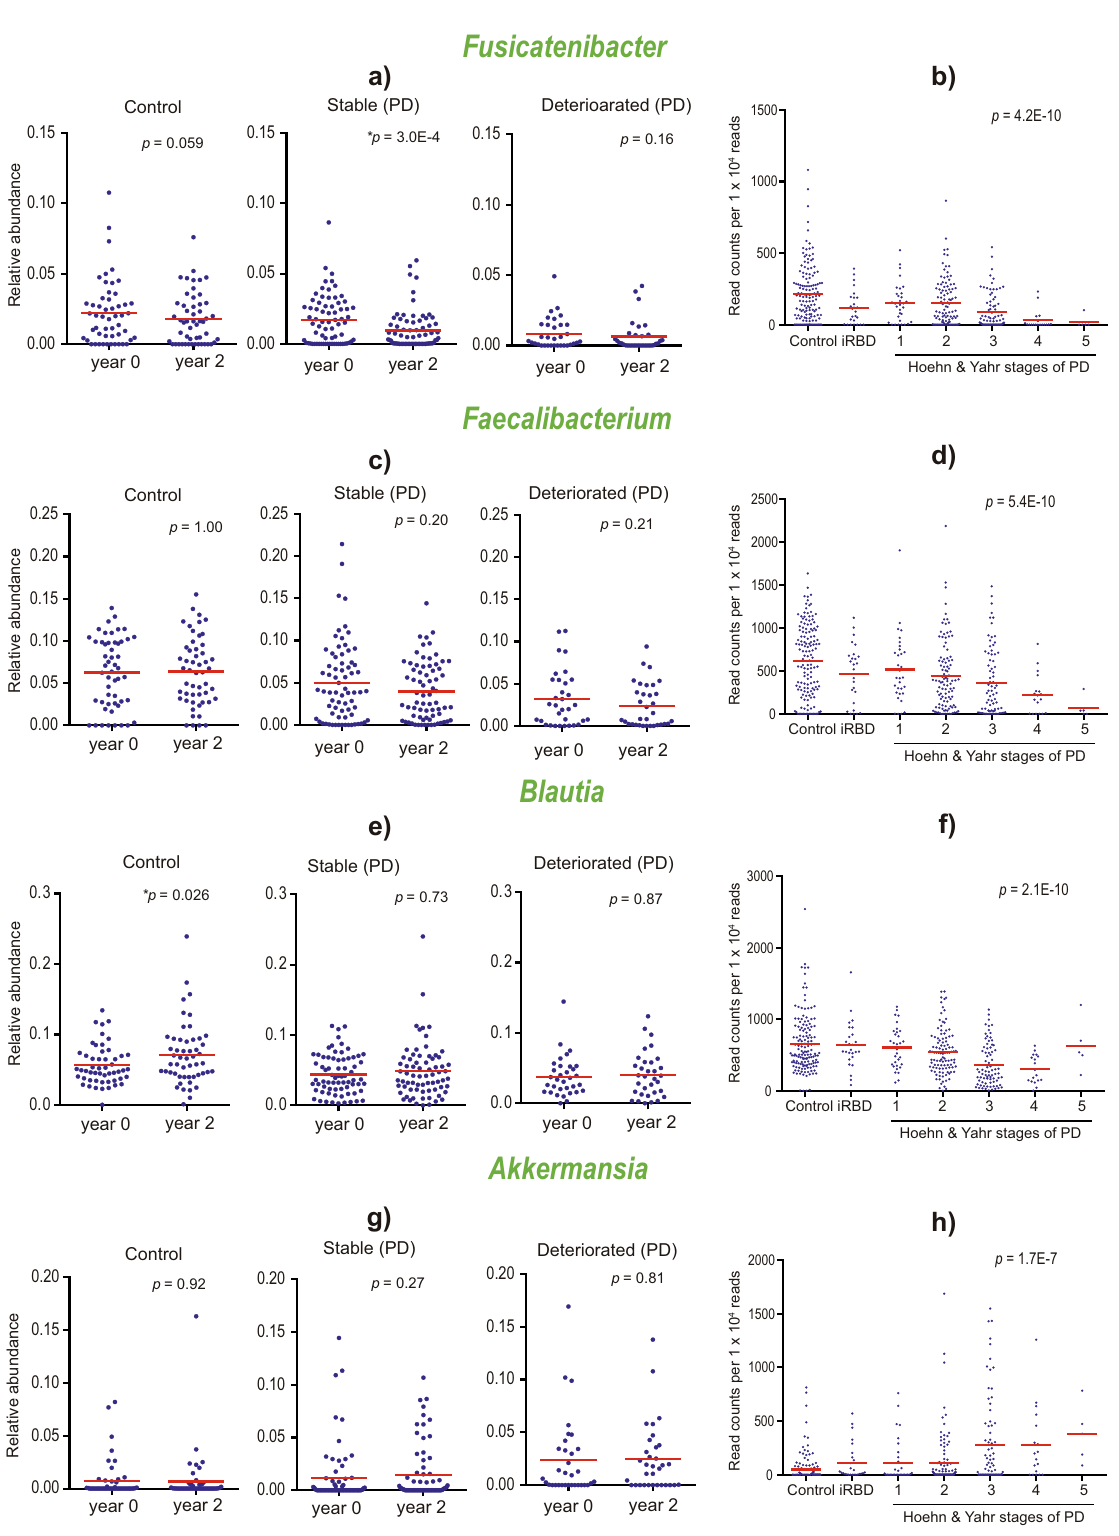
Fig. 4 Changes of four essential genera in two years and in the course of disease progression. Relative abundances of genera Fusicatenibacter , Faecalibacterium , Blautia , and Akkermansia at years 0 and 2 in the control, stable, and deteriorated groups of combined HY stages 1 – 3 ( a, c, e, and g ), as well as at year 0 in controls, iRBD, and HY stages 1 – 5 ( b, d, f, and h ). The four genera constituted features to make the highest AUROC models (Fig. 2 and Supplementary Table S5) and were signi fi cantly changed in PD in our dataset in our previous analysis 38 . Means are indicated by red bars. a, c, e, and g P -values were calculated by the Wilcoxon signed-rank test. * P < 0.05. Means are indicated by red bars. b, d, f, and h P -values are calculated by Jonckheere-Terpstra trend test to indicate whether the relative abundances increase or decrease monotonically. Plots of genera Faecalibacterium ( d ) and Akkermansia ( h ) with the progression of α -synucleinopathy were previously reported with fewer numbers of samples 42